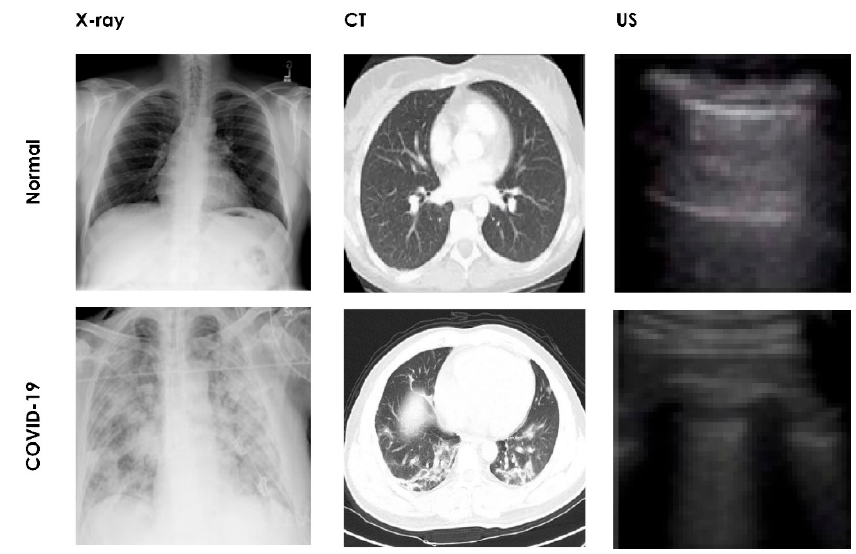
Figure 4. Sample images using various medical image